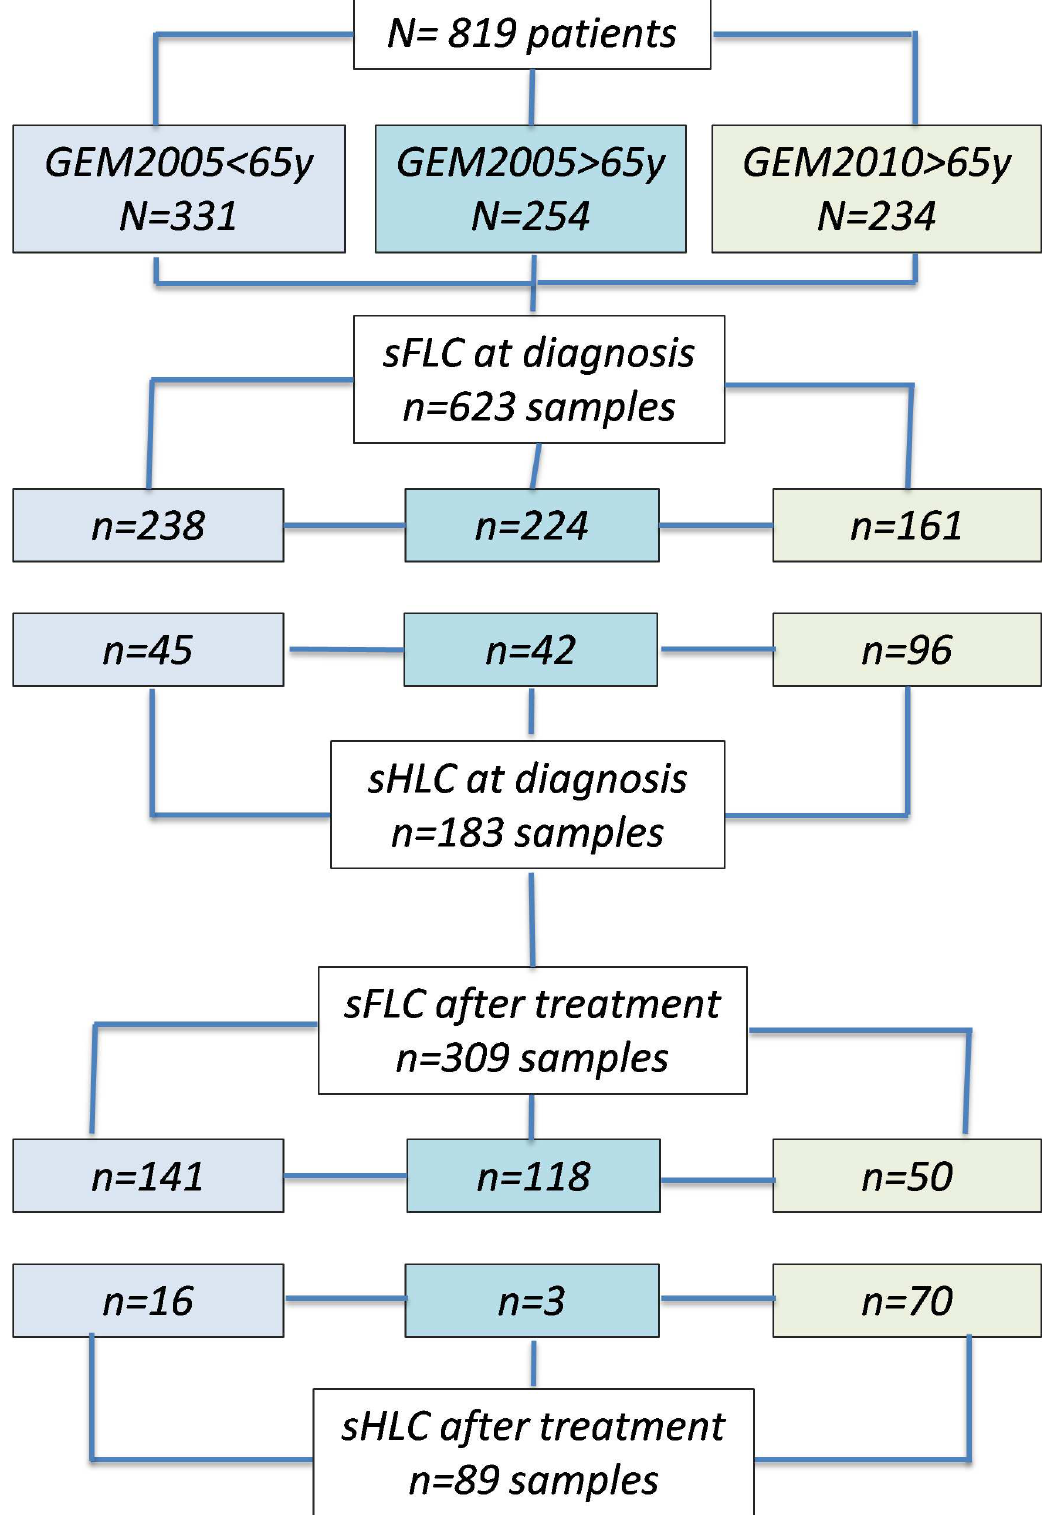
Fig 1. Flow chart: Patient inclusion and analyzed